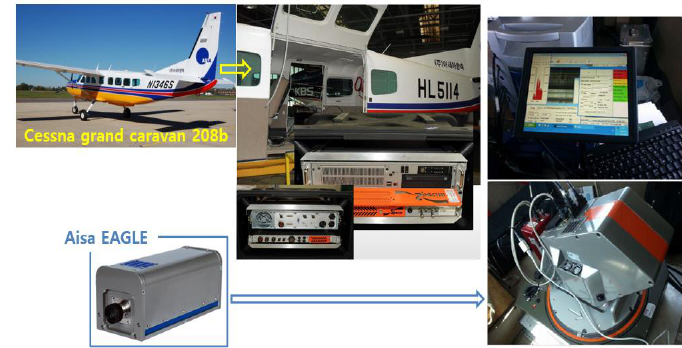
Figure 2 . AisaEAGLE sensor mounted on the Cessna 208b aircraft and internal equipment installation.